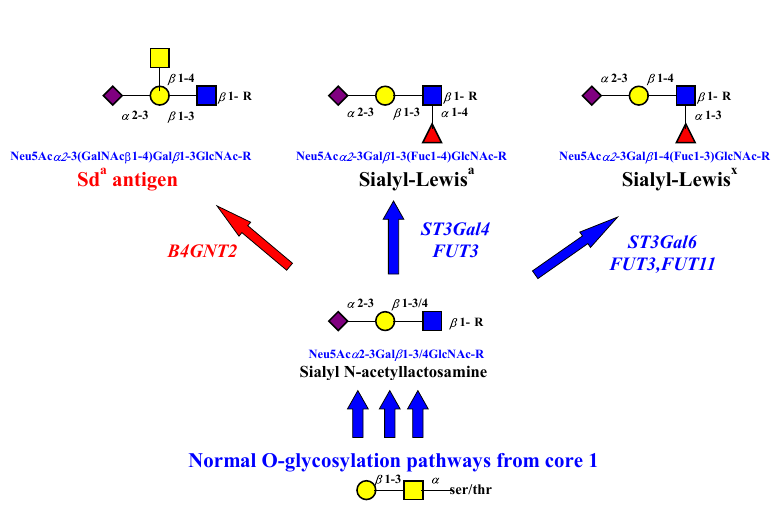
Figure 2. Biosynthetic Routes to the Sd a antigen. The sequential steps leading to the Sd a antigen from core 1, via sialyl- N -acetyllactosamineare shown. The individual glycosyltransferases for each step are indicated. The red arrow indicates the major pathway, while the blue arrows indicate competing steps to the sialyl-Lewis a and sialyl-Lewis x antigens. Abbreviations and monosaccharide symbols are given at the end of the paper.